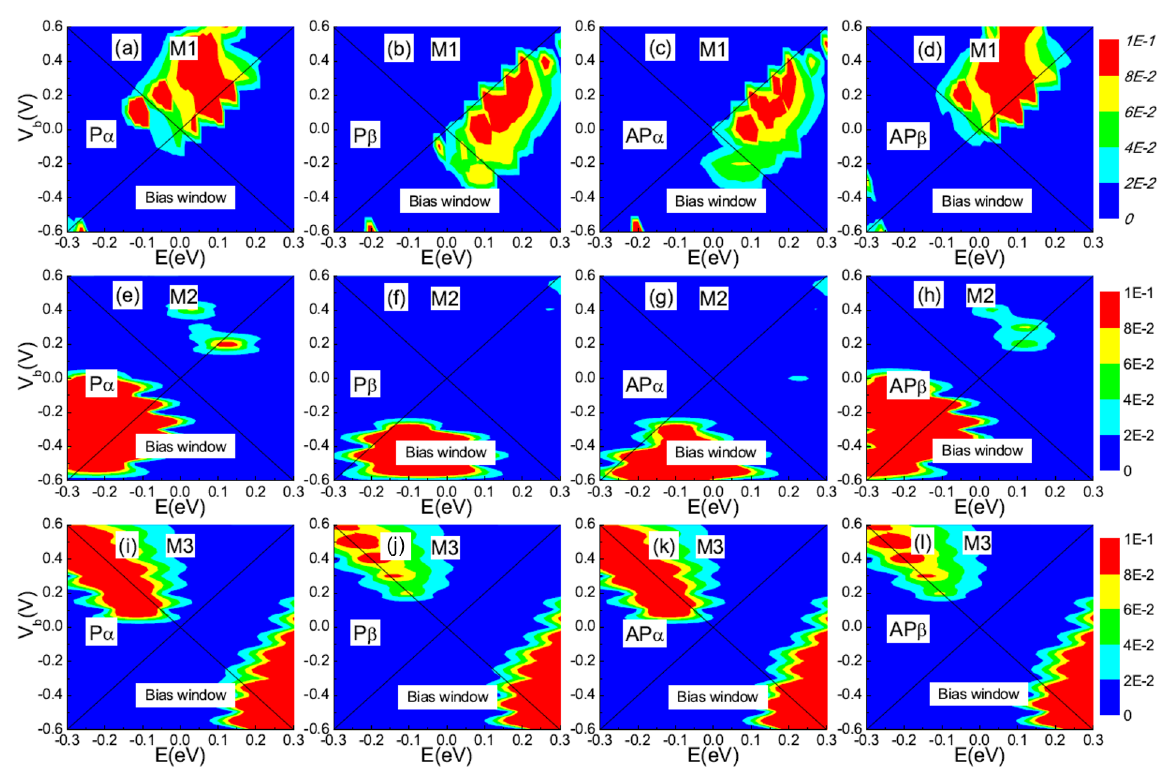
Figure 6. (Color online) 3D plot of the spin-resolved transmission spectra on the E-V b plane, where ( a – d ) corresponds to M1 in P/AP configuration, respectively. ( e – h ) and ( i – l ) The same as ( a – d ) for M2 and M3, respectively. The (black) cross line region is referred to as the bias